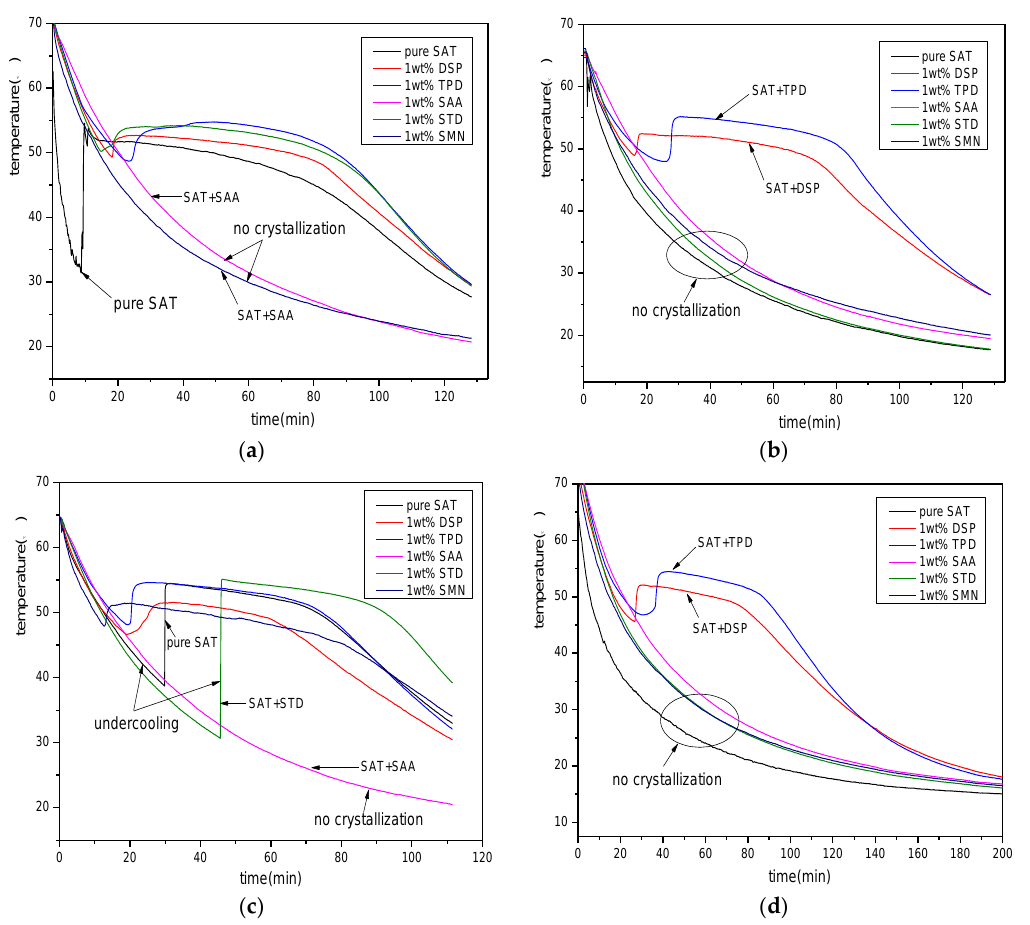
Figure 2. The discharging curves of samples after adding nucleating agents. ( a ) the first discharging curves; ( b ) the second discharging curves; ( c ) the third discharging curves; ( d ) the fourth discharging curves.